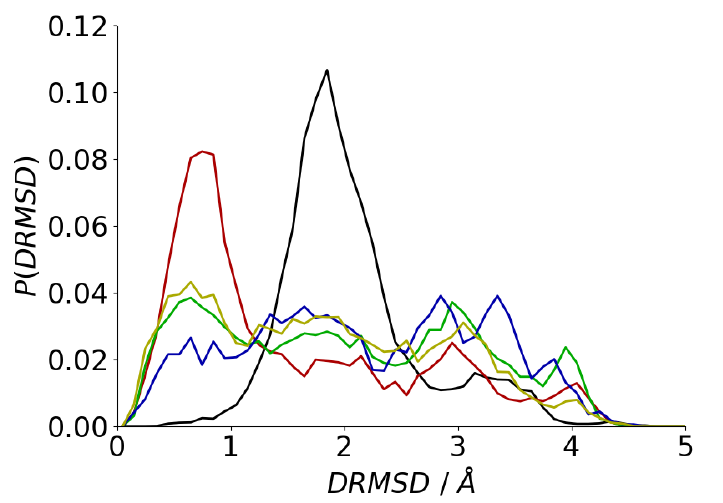
Figure 6. Histogram of DRMSD relative to experimental fibril structure for Au111 (black), Au100 (red), Ag111 (green), Ag100 (blue) surfaces, and bulk solution (yellow).